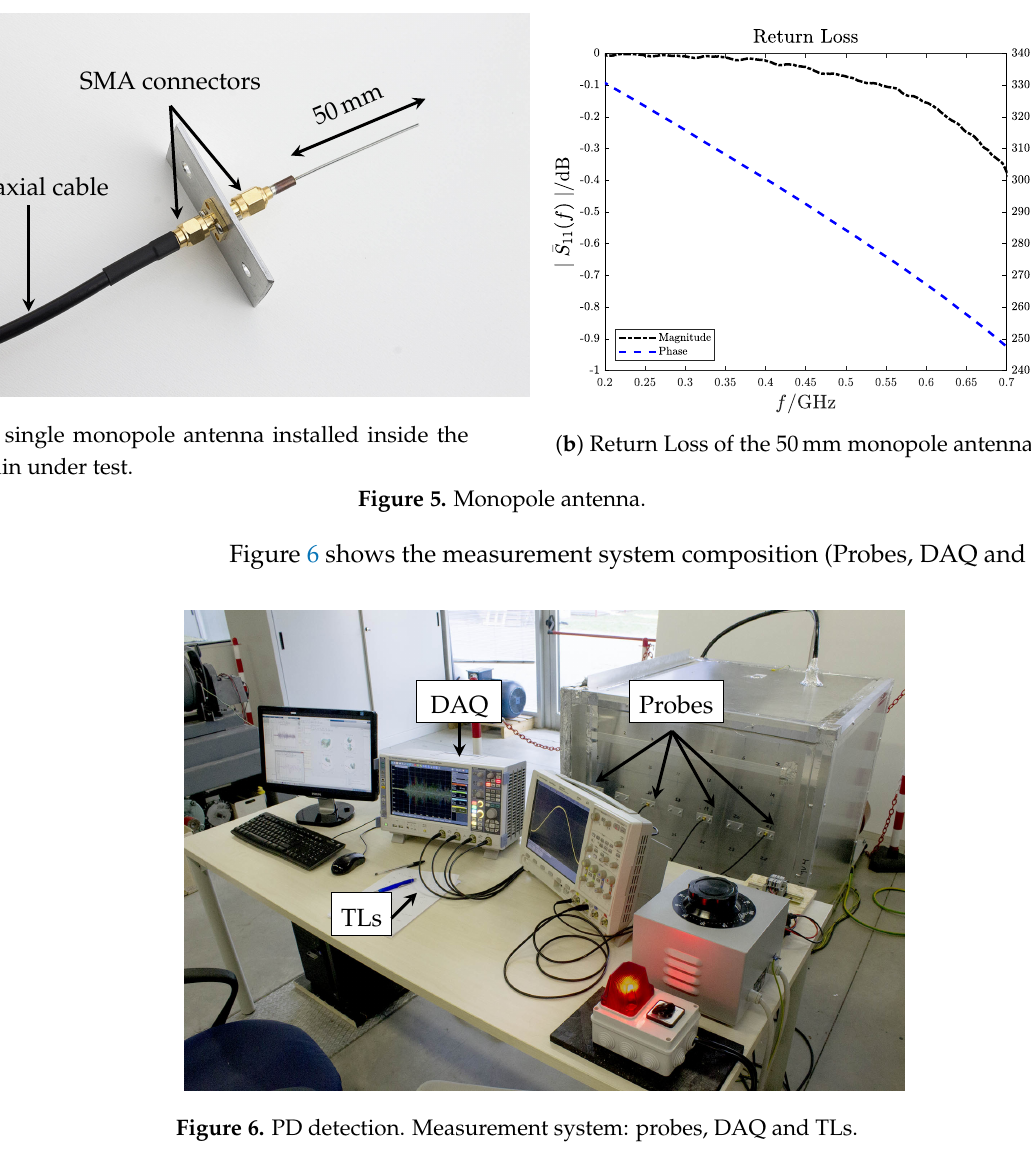
Figure 6. PD detection. Measurement system: probes, DAQ and